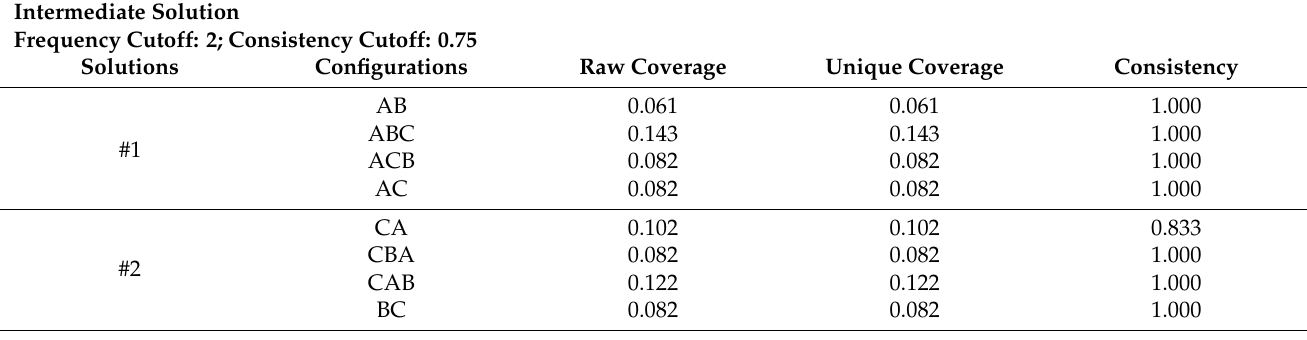
Table 7. The visual scan path configuration (Hazard